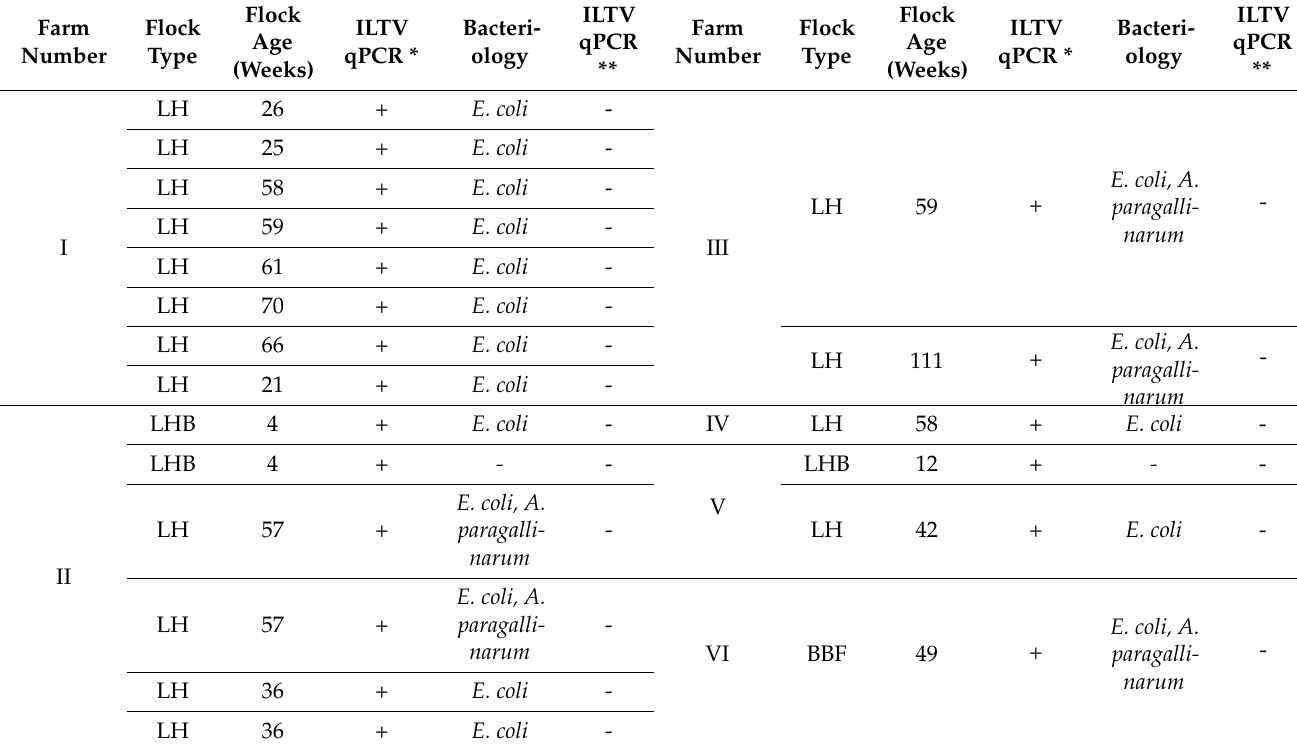
Table 3. Results of bacteriological and molecular analyzes from all